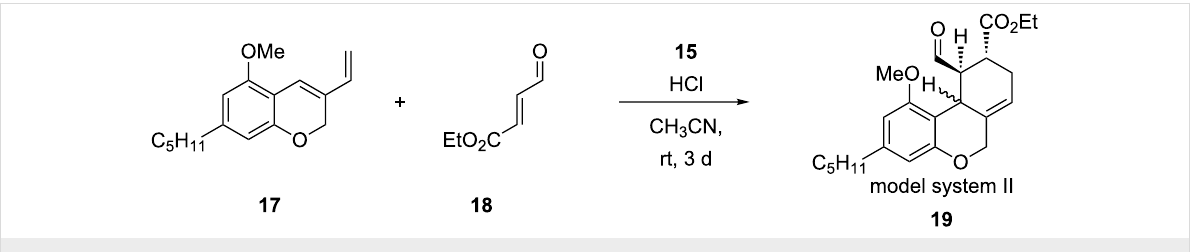
Scheme 5: Screening of imidazolidinone catalysts 15 .